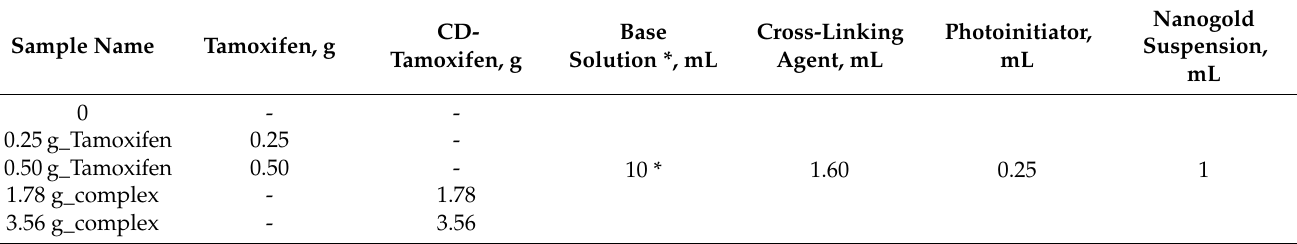
Table 1. Compositions of polymer